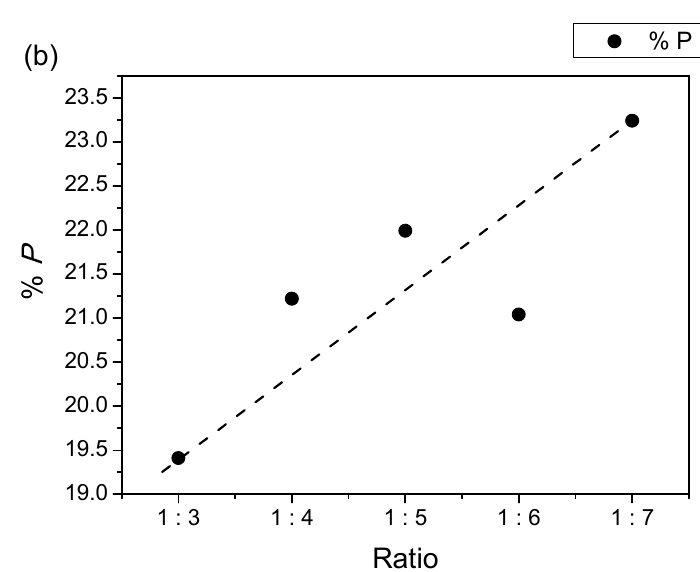
Figure 5. Relationship of ( a ) grain size, D , and ( b ) percentage of porosity, % P at various ratios of BaFe 12 O 19 .